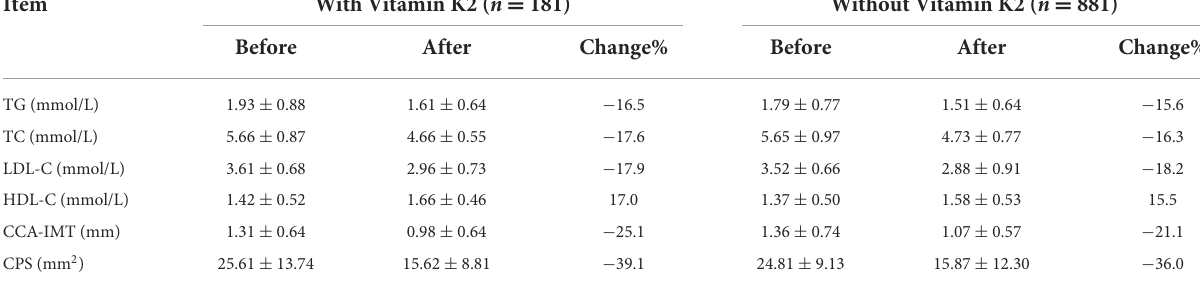
TABLE 11 Effect of co-administration of vitamin K2 (180 µ g daily) on NK action.